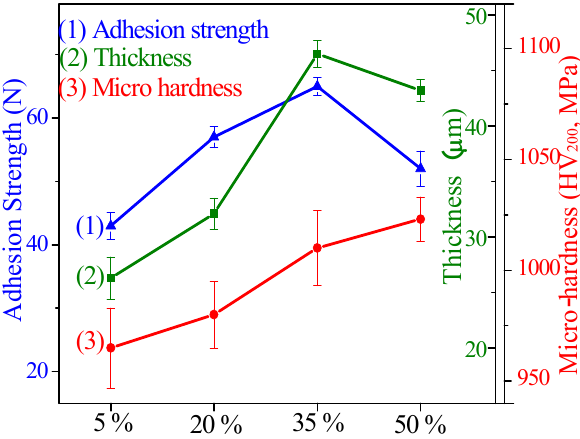
Figure 7. The thickness, micro–hardness, and adhesion strength of CPED coatings.